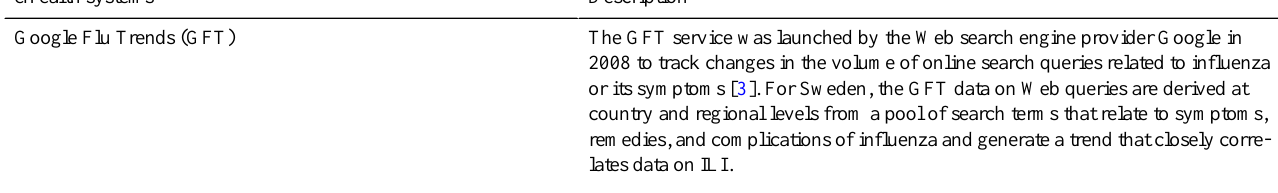
Table 1. eHealth systems in Östergötland county, Sweden, investigated in the study. DescriptioneHealth